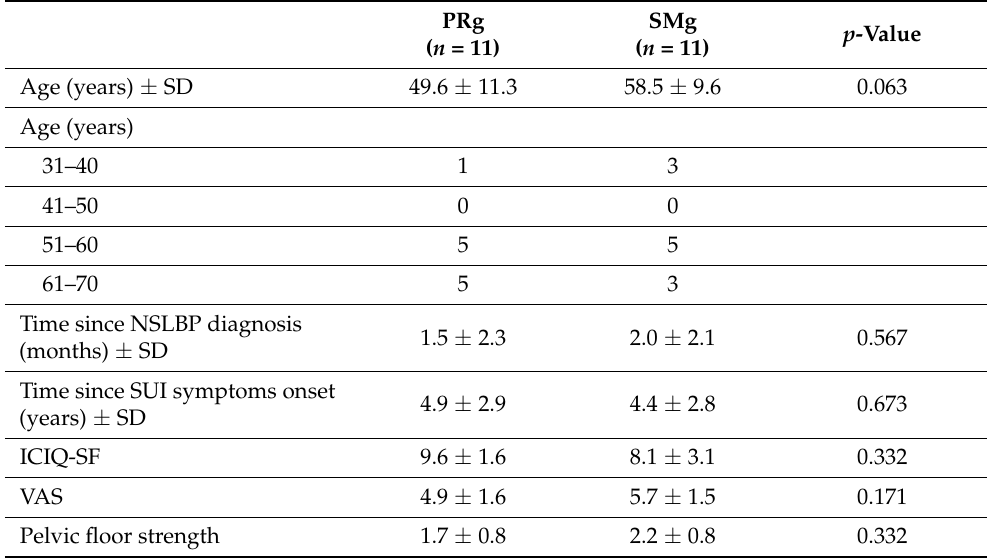
Table 1. Demographic and clinical characteristics at the baseline of the trial.